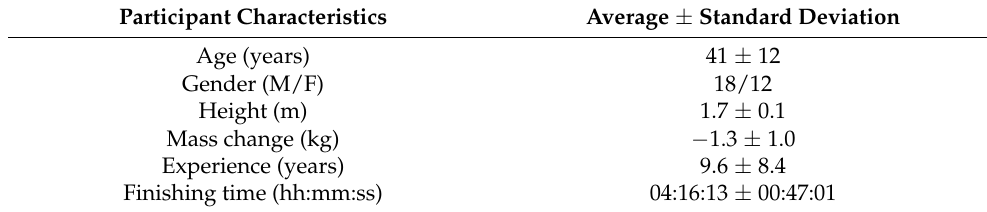
Table 2. Participant demographic